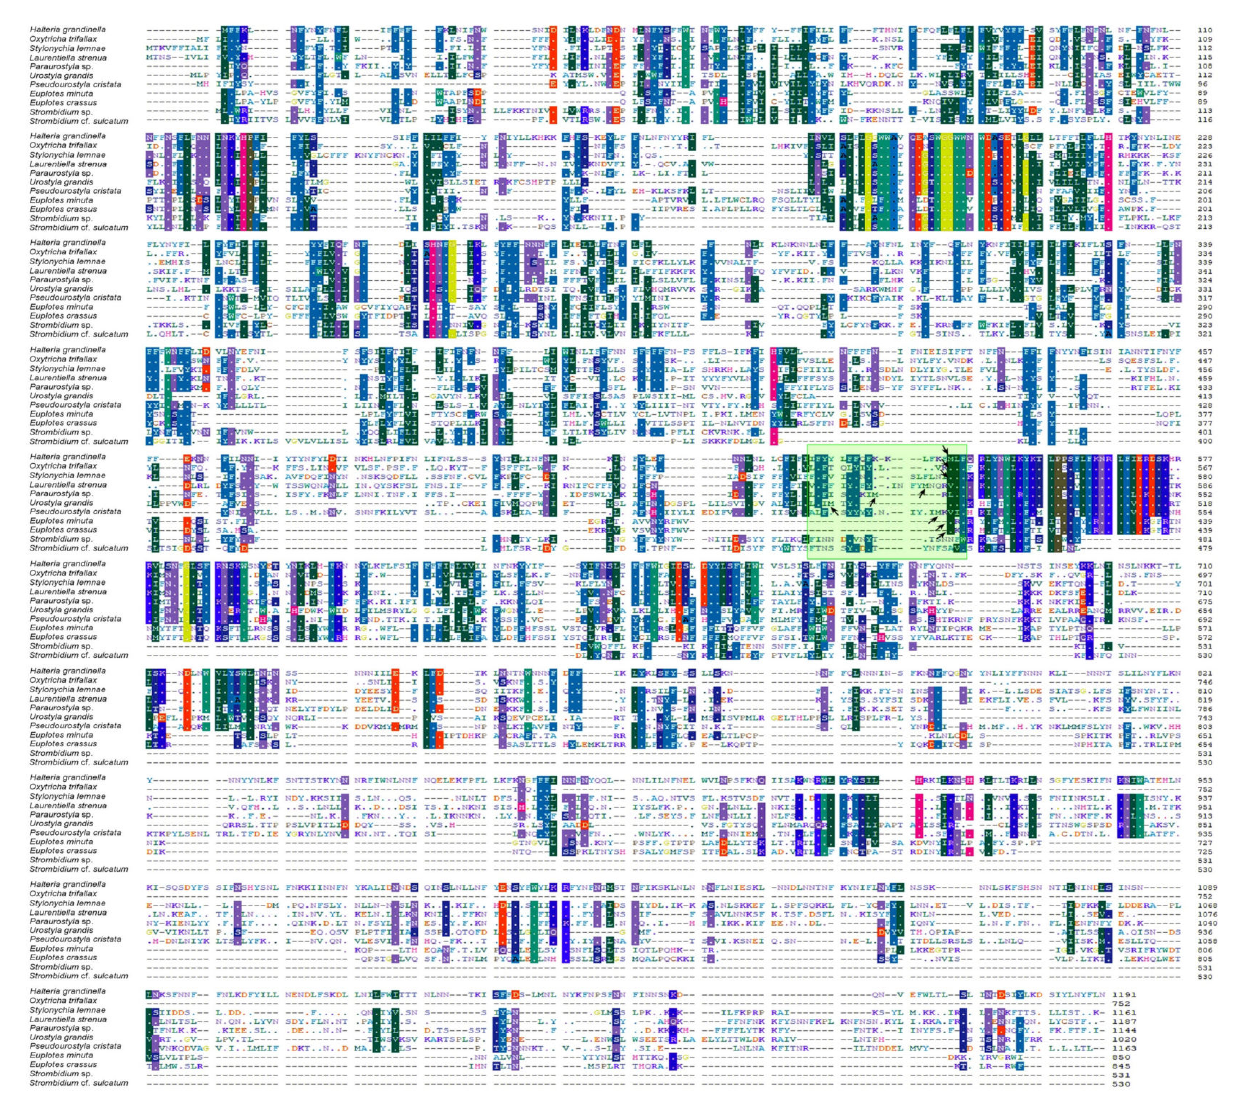
Figure 6. Sequence alignment of ccmf proteins of mitogenomes in Spirotrichea. Regions with substantial sequence similarity are indicated in color shade. Arrow indicates the concatenation points of ccmf_i and